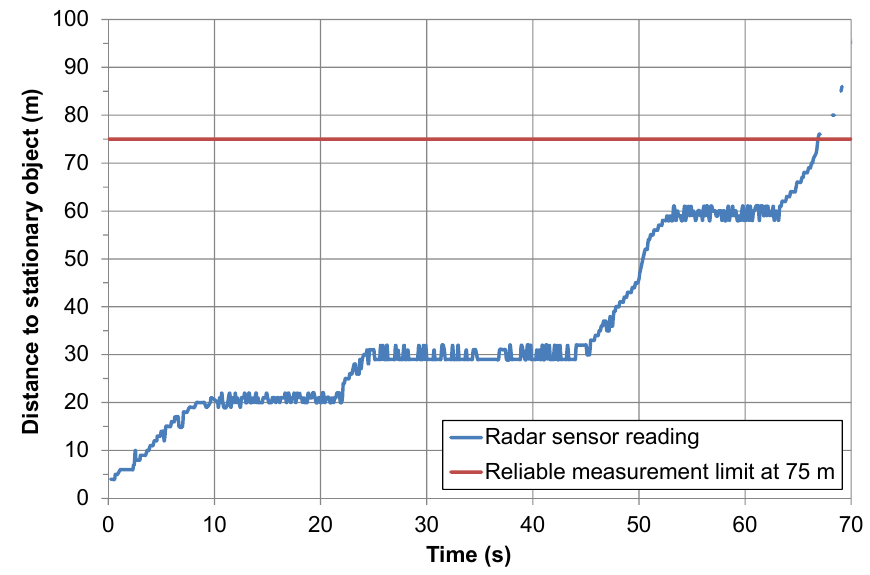
Figure 8. Example distance measurement from a stationary object. Table 3. Distance-to-object measurement test statistics.